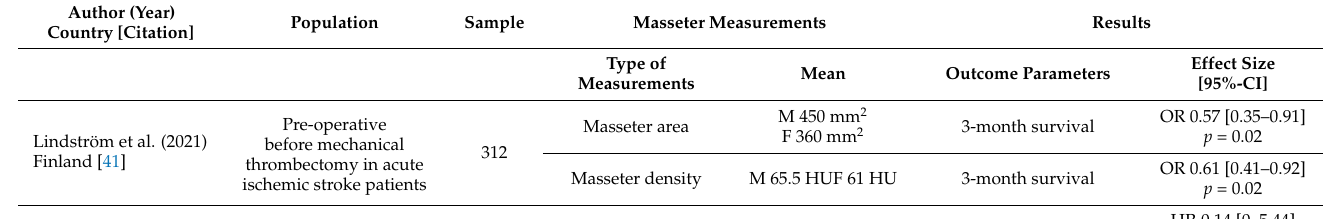
Table 4. An overview of existing literature regarding CT-based masseter measurements and surgi- cal